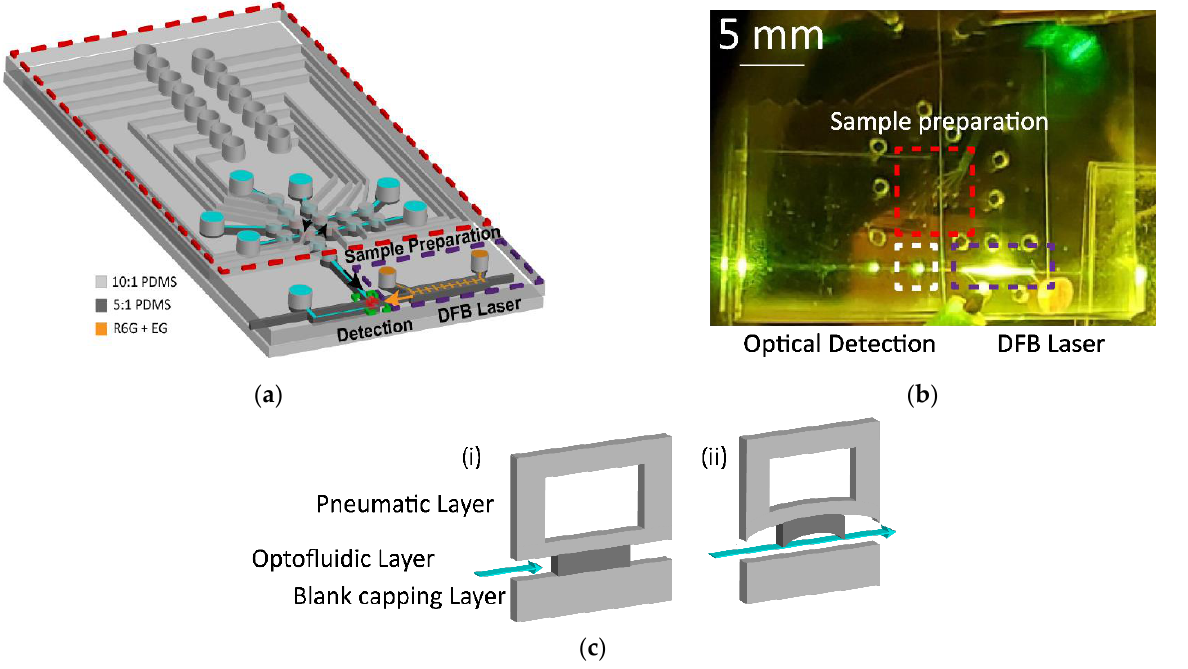
Figure 2. ( a ) PDMS device consisting of three distinct functional regions: sample preparation (red), light source (purple), and detection (green). ( b ) Top-down camera image of all-in-one chip. Scattering of DFB emission is visible through a long-pass filter that blocks pump laser. ( c ) Cross sectional diagrams of pneumatic lifting-gate valve structures with positive pressure used to close valves (i) and negative pressure used to lift valves and allows fluid flow (ii).